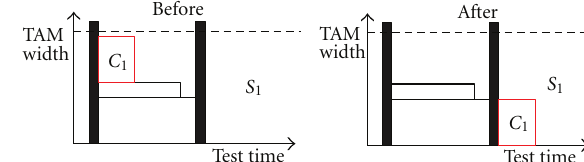
Figure 6: Move-to-empty-slot perturbation.